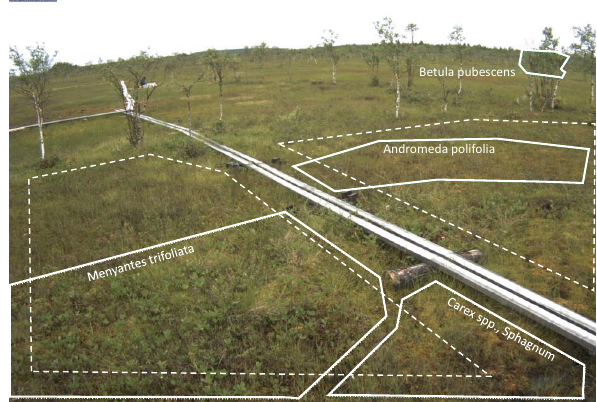
Figure 1. View from the wetland camera. The solid lines indicate four regions of interest defined according to vegetation types. The dashed lines indicate the region of interest that includes all vegeta- tion types except Betula pubescens